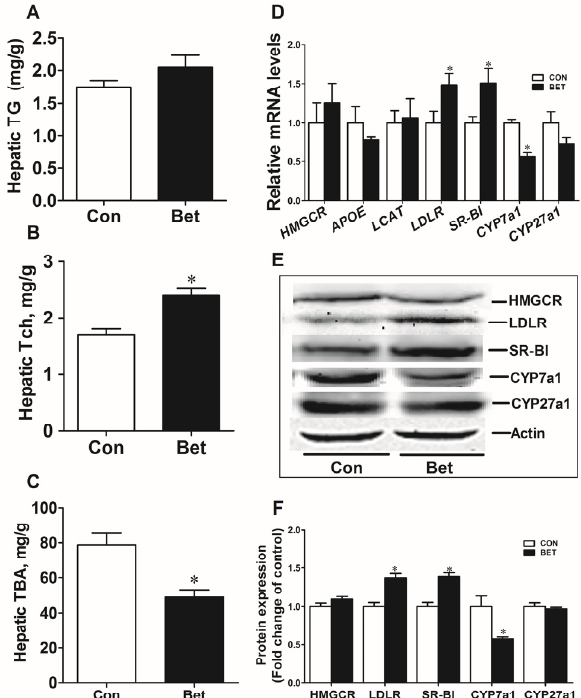
Figure 1. Hepatic triglycerides ( A ); total cholesterol ( B ); and total bile acids ( C ) of the offspring piglets at weaning; hepatic mRNA level ( D ); Western blotting analysis and graphic summary ( E , F ) of cholesterol metabolic genes in the liver of weaning piglets. Values are means ± SEM, n = 8. Different from control, * p < 0.05.